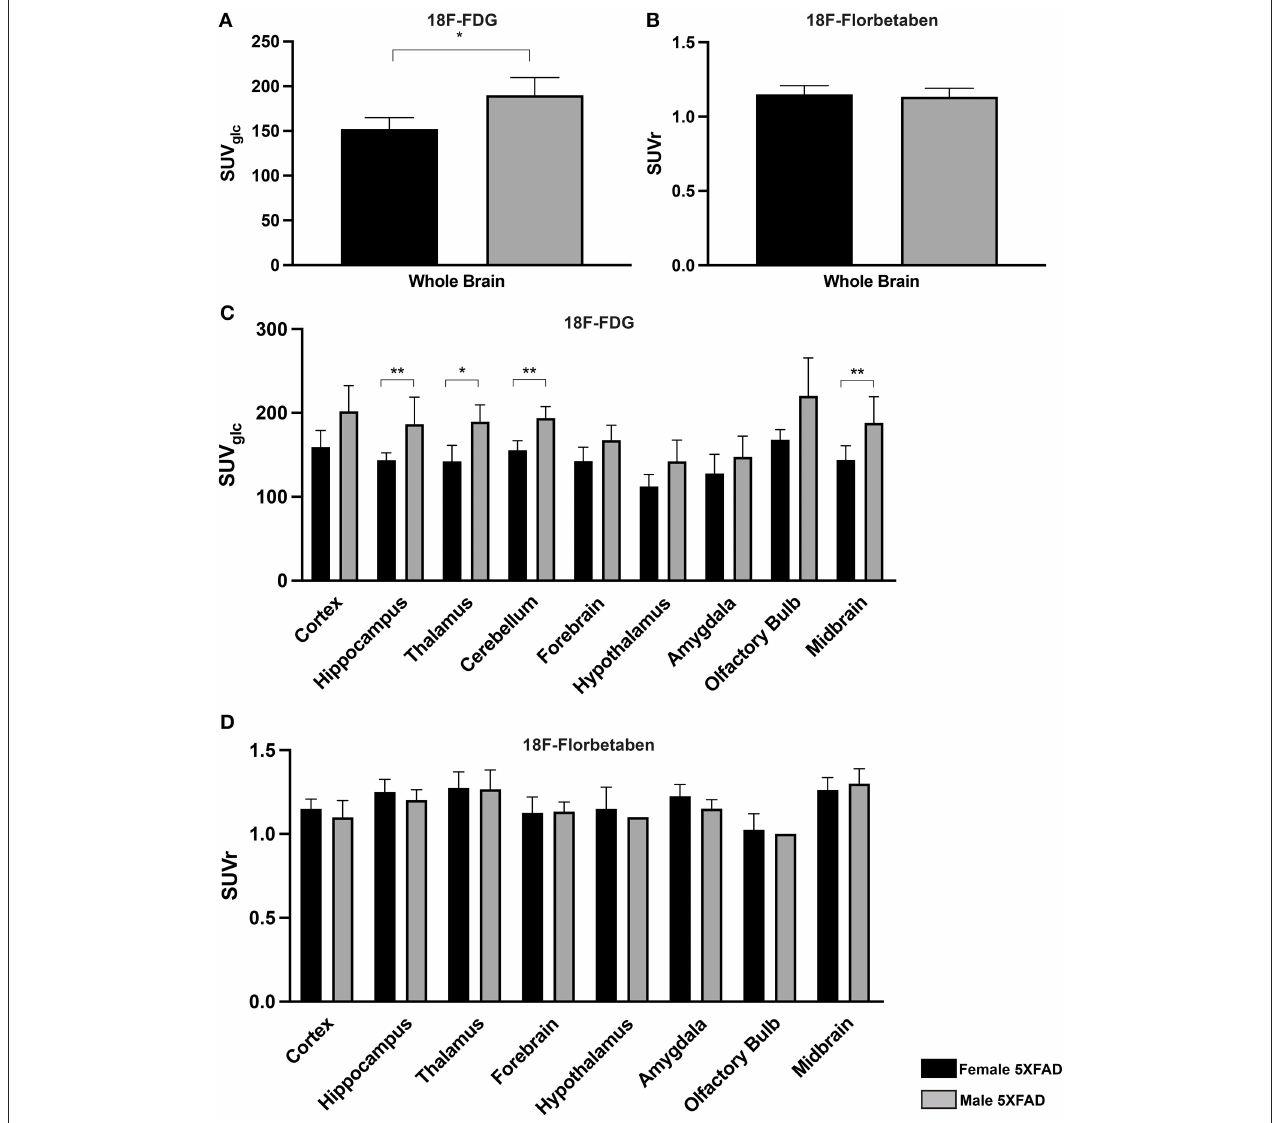
FIGURE 3 | Sex differences in 7-month-old 5XFAD mice. (A,C) 18F-FDG uptake in 7-month-old female 5XFAD mice showed significantly lower SUVglc in the whole brain compared to 7-month-old male 5XFAD mice. Differences could be detected in the hippocampus, thalamus, cerebellum, and midbrain. (B) 7-month-old female 5XFAD mice did not show significant differences in 18F-Florbetaben uptake compared to 7-month-old male 5XFAD mice in the whole brain or in (D) any of the analyzed brain regions. Unpaired t -test; * p < 0.05; ** p < 0.01; data presented as mean + /-